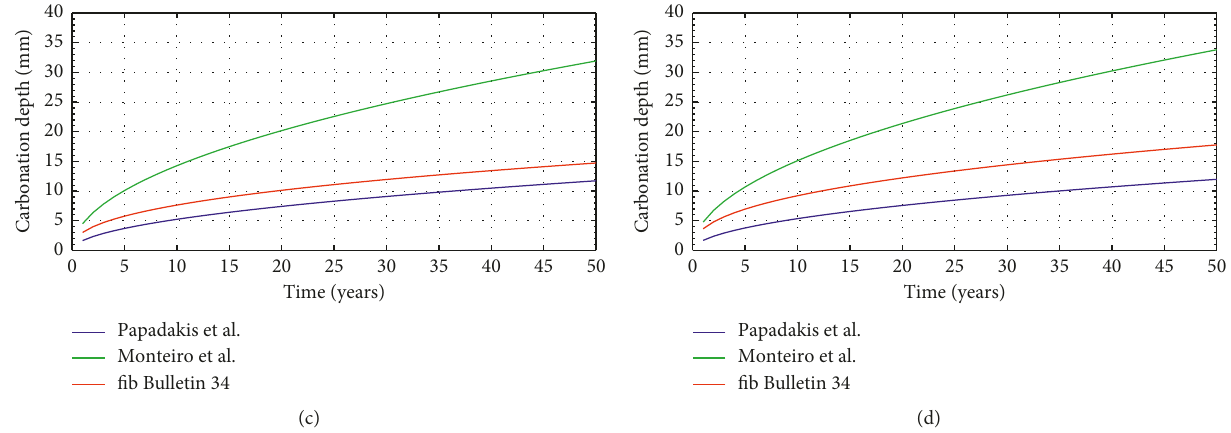
Figure 6: Comparison between models’ prediction of carbonation depth versus service life: XC2 exposure class: w/c � 0.60. (a) R � 0%; (b) R � 20%; (c) R � 50%; (d) R � 100%.